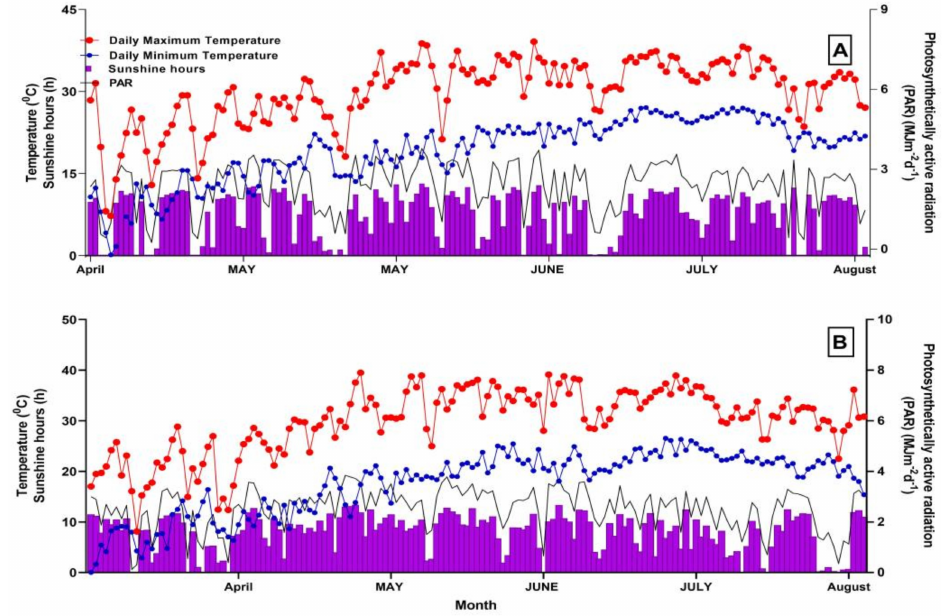
Figure 1. Monthly meteorological conditions during cotton growing season in 2018 and 2019 ( A , B